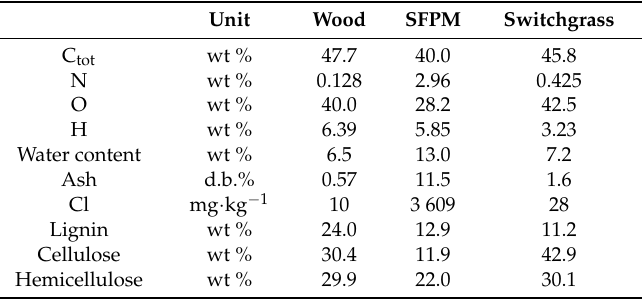
Table 2. Biomasses physicochemical properties.